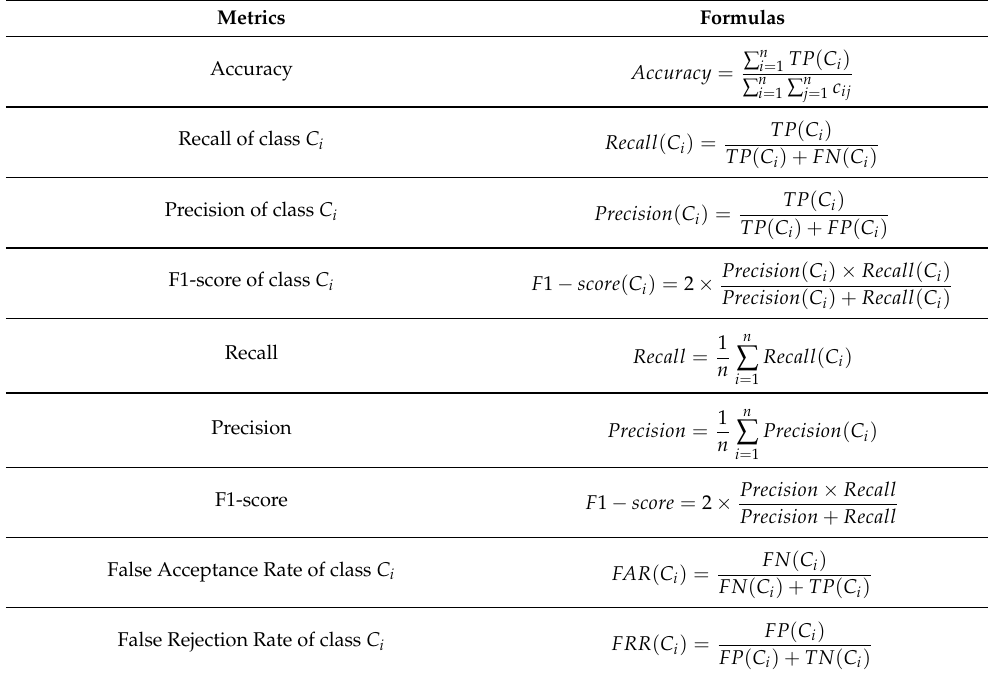
Table 3. Performance metrics for a multiclass confusion matrix. Metrics